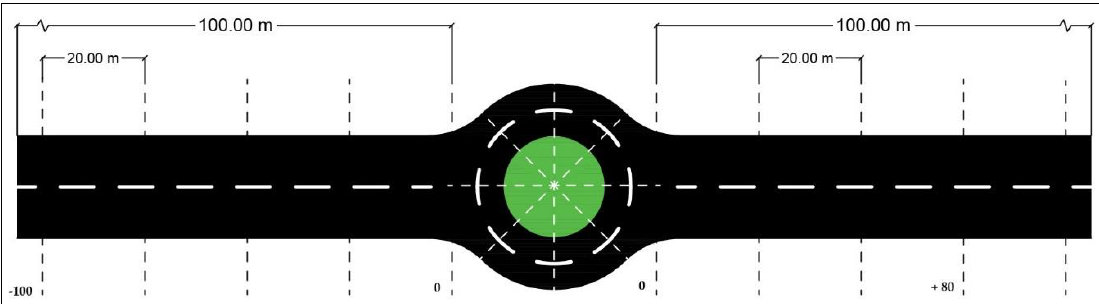
Figure 9. Roundabout segmentation in the before, during, and after sections.